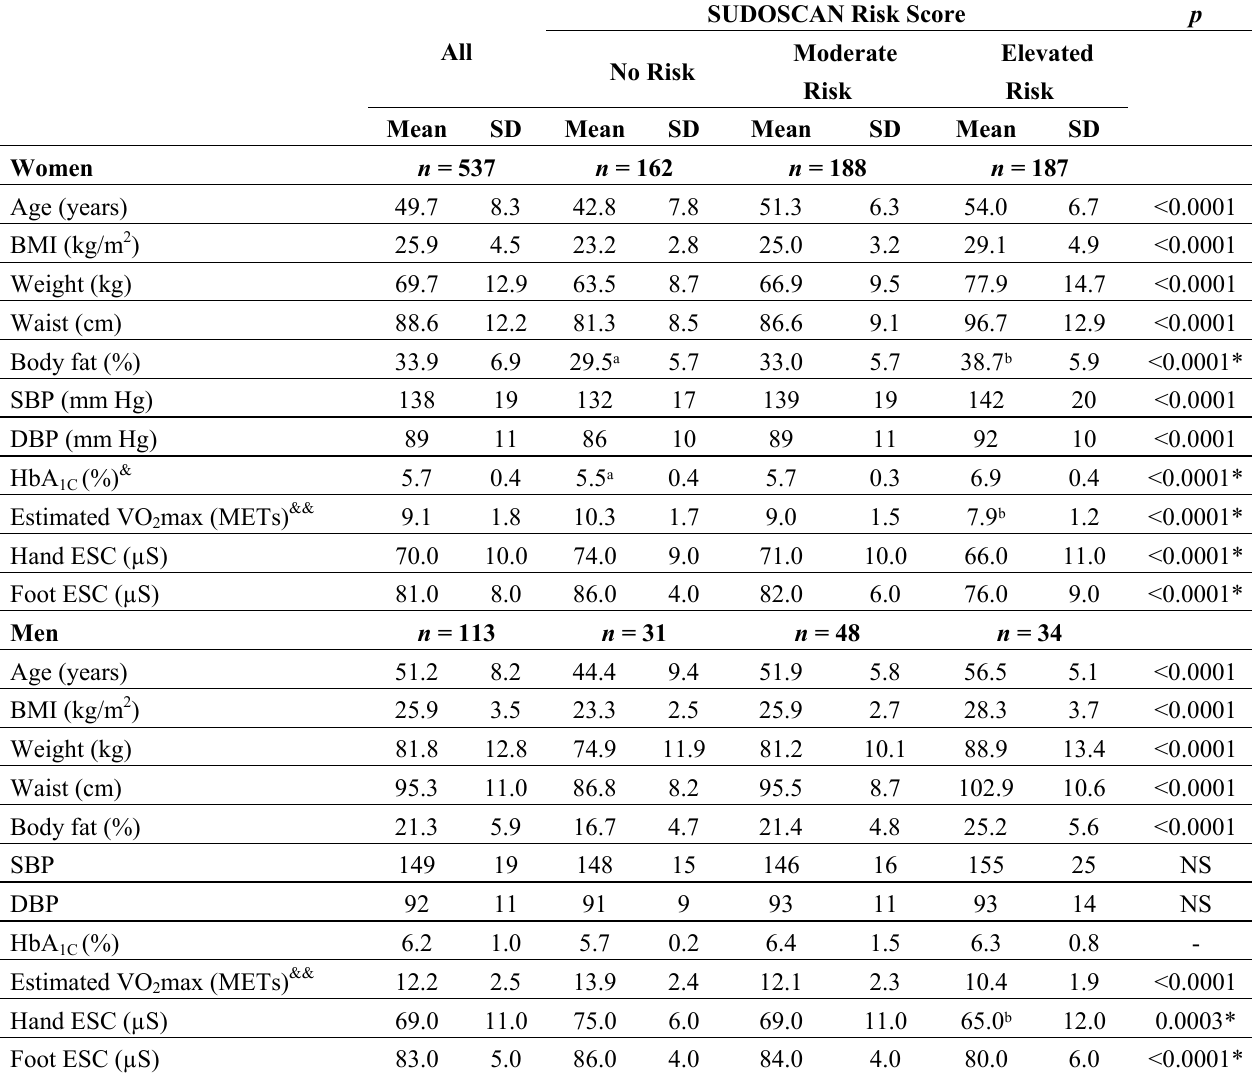
Table 1. Baseline Values for the Main Study Parameters according to SUDOSCAN Risk Score based on Sudomotor Dysfunction in Study Population by Gender.